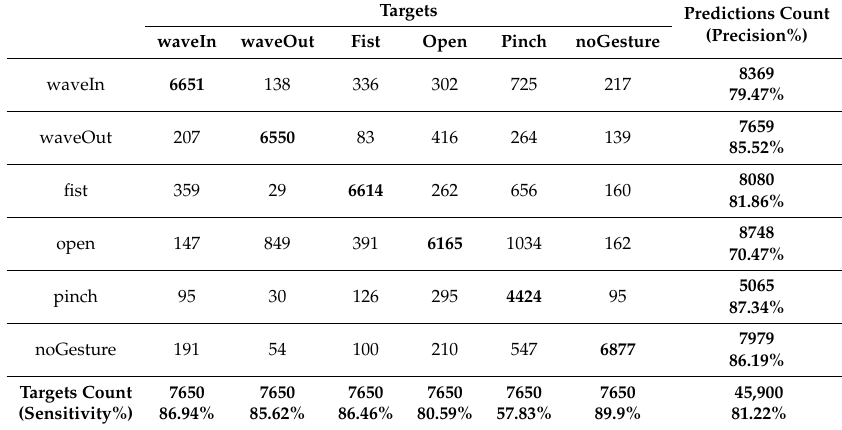
Table 10. Confusion matrix of experiment 4 for the user-general model. Rotation of the bracelet = YES (on training and test set), orientation correction = YES . Best result with four synchronization gestures ( sync = 4 ) to select the maximum average energy sensor s x . Classification accuracy =